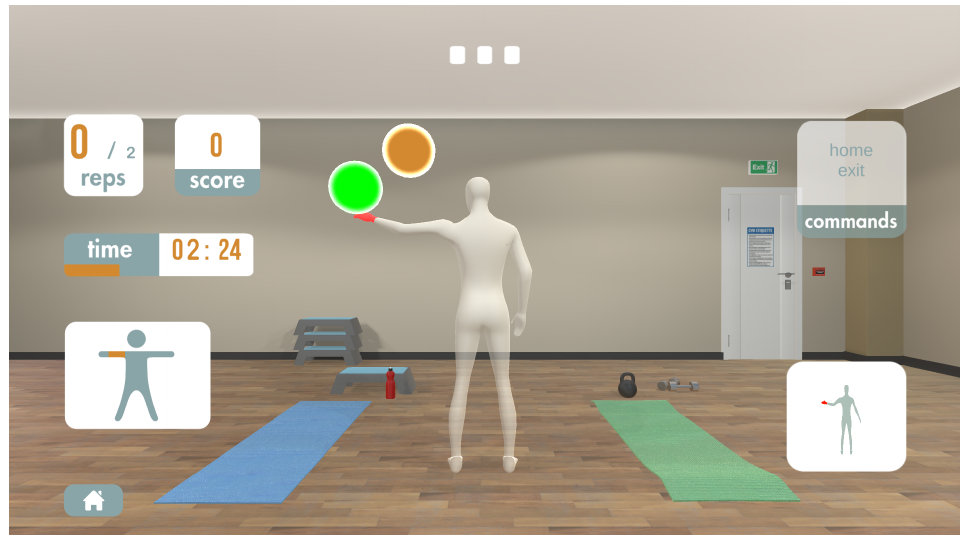
Figure 9. Left shoulder abduction representation.